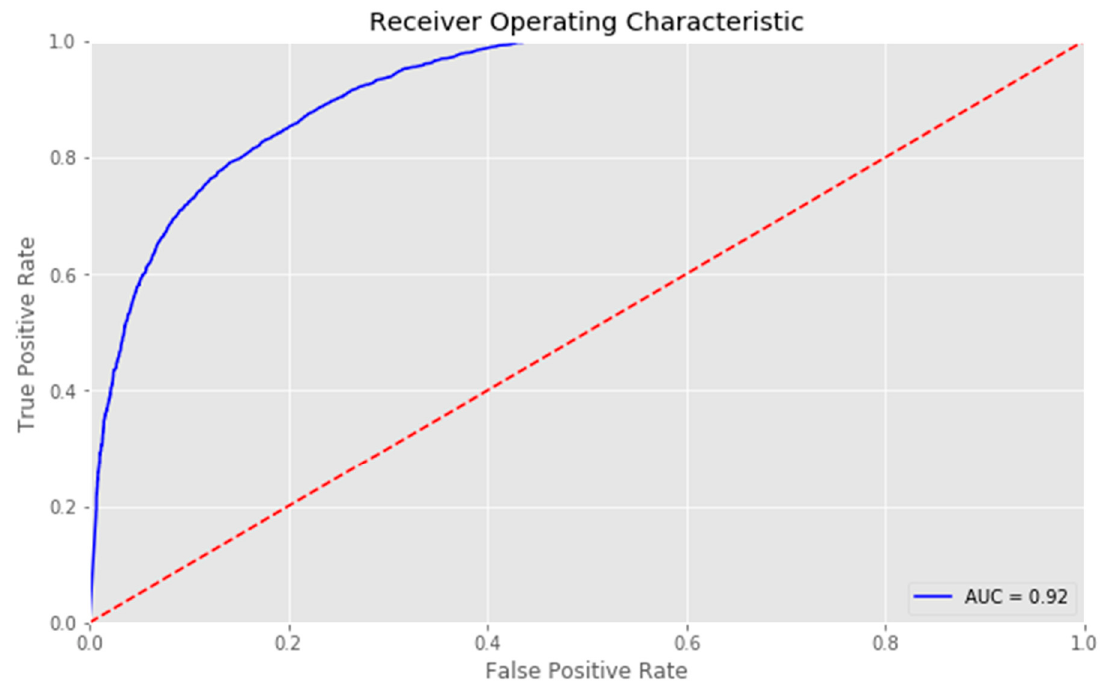
Figure 2. Receiver operating characteristic curve in risk prediction of unmet dental care needs using deep deep learning.